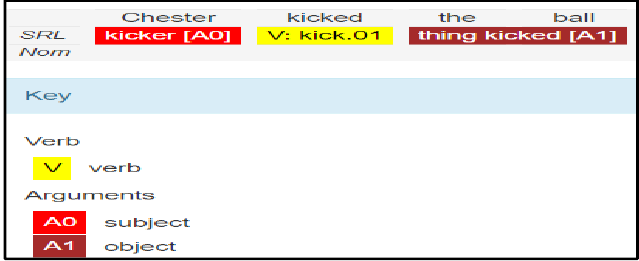
Figure 3. An analysis of the original phrase based on SRL.